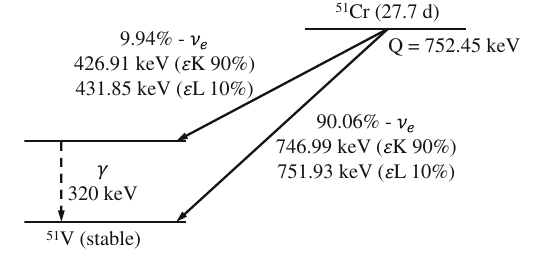
Fig. 1 51 Cr decay scheme [25]